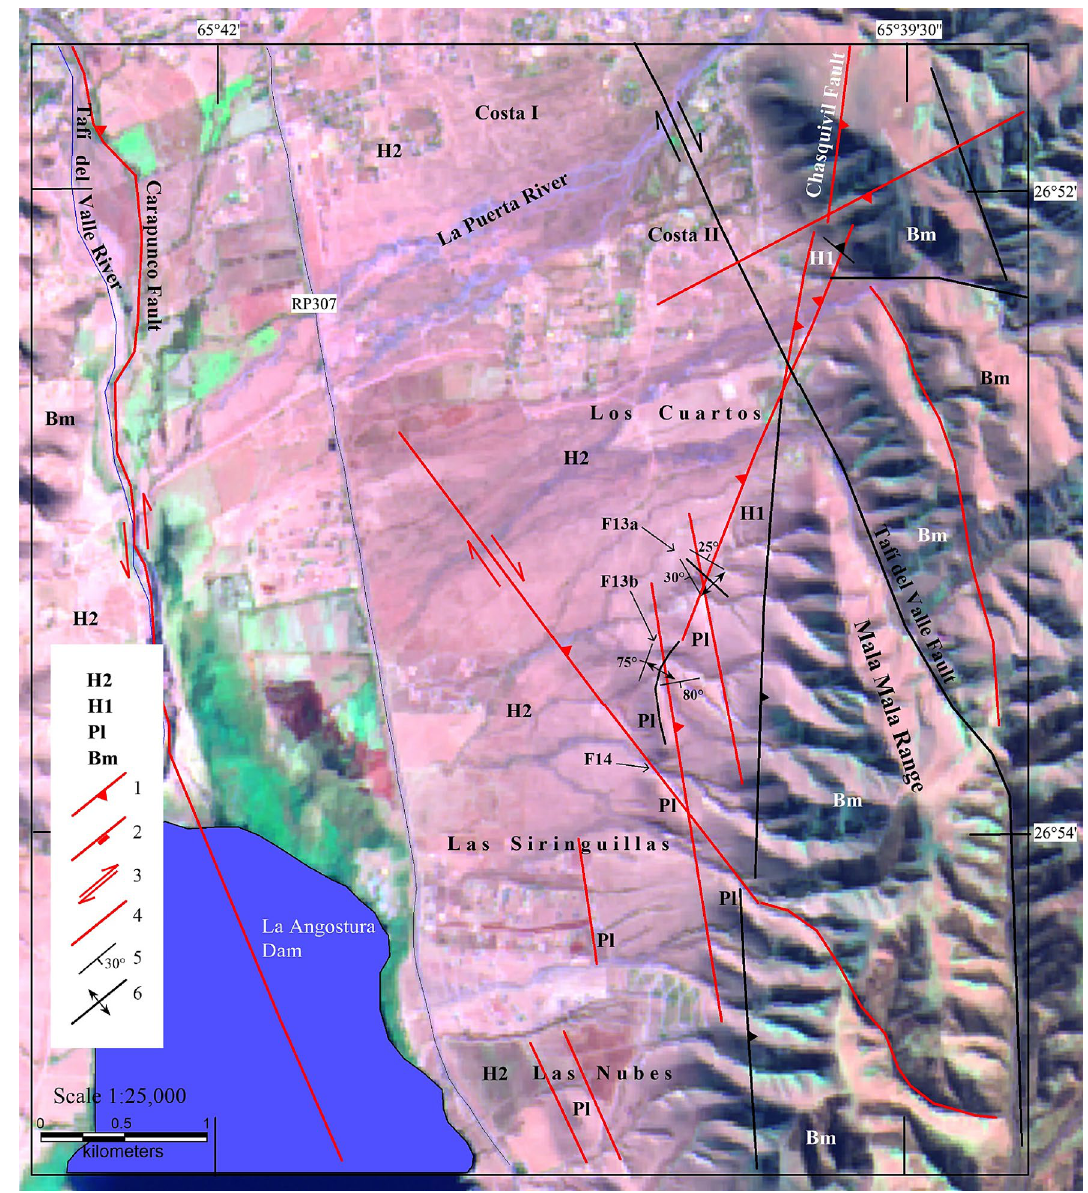
Lower Paleozoic. Recent structures are shown in red and old struc‑ tures in black. 1: Reverse fault. 2: Normal fault. 3: Transcurrent fault. 4: Lineaments. 5: Bedding strike and dip. 6: Anticline fold. F13 and F14 indicate the location of these